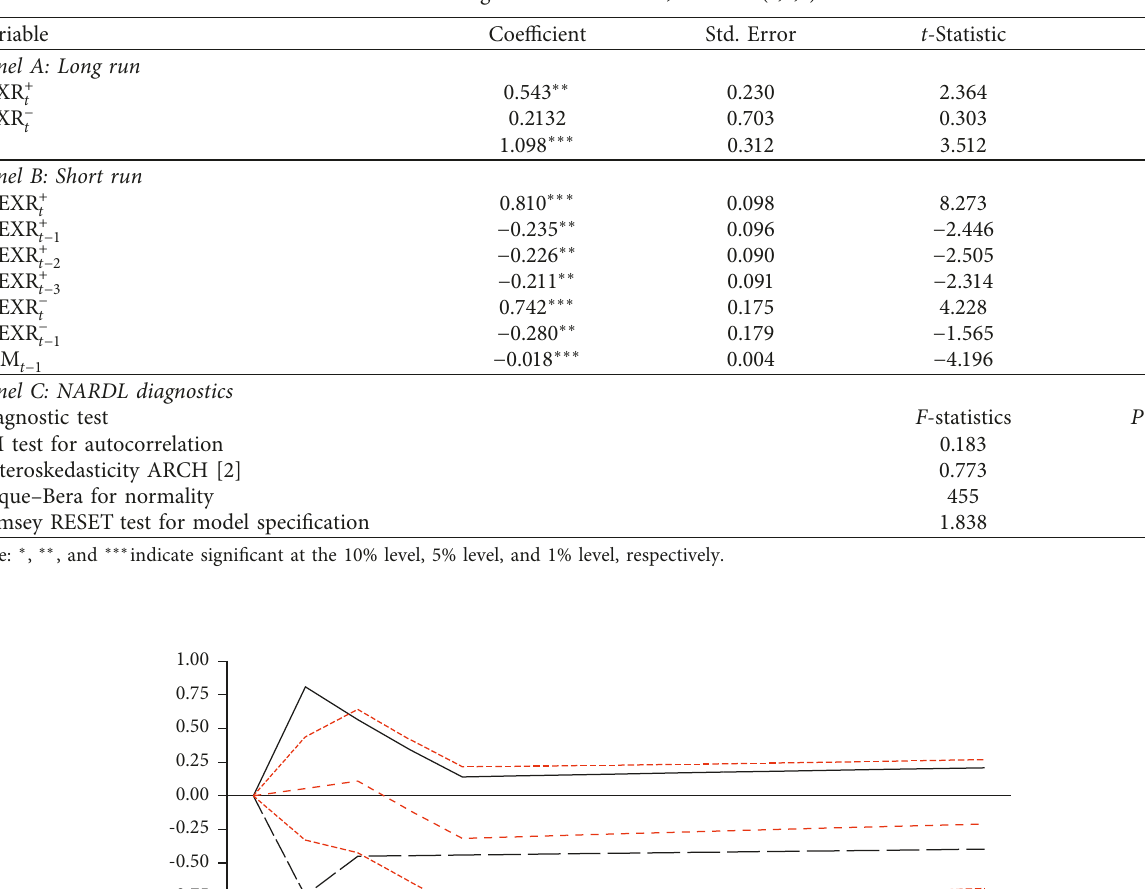
Table 6: Long run and short run, NARDL (1,4,2).